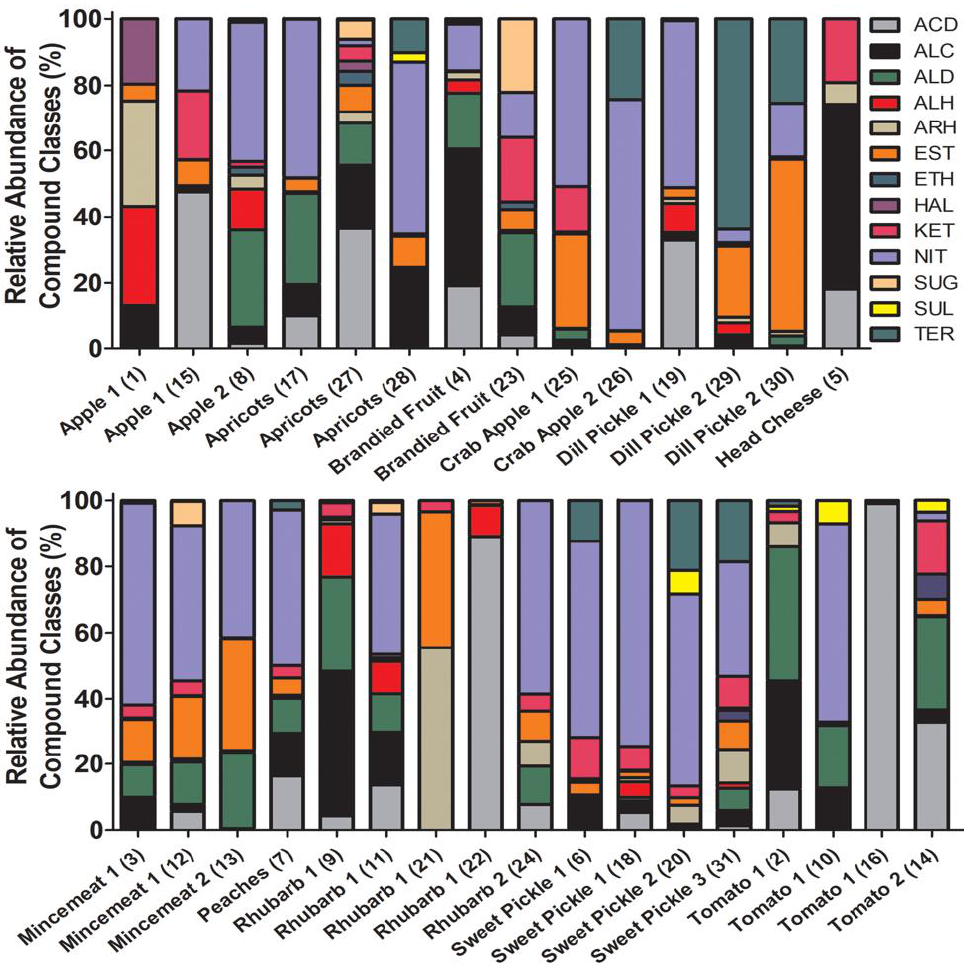
Figure 3. The relative abundance of the assessed compound classes (as percent of total) in the historical preserves. Samples are ordered alphabetically by type, and the sample number is in parenthesis after the sample type. Compound classes presented as colors are defined as follows: ACD = acids; ALC = alcohols; ALD = aldehydes; ALH = aliphatic hydrocarbons; ARH = aromatic hydrocarbons; EST = esters; ETH = ethers; HAL = halogen-containing; KET = ketones; NIT = nitrogen-containing; SUG = sugar alcohols; SUL = sulfur-containing; TER = terpenoids.